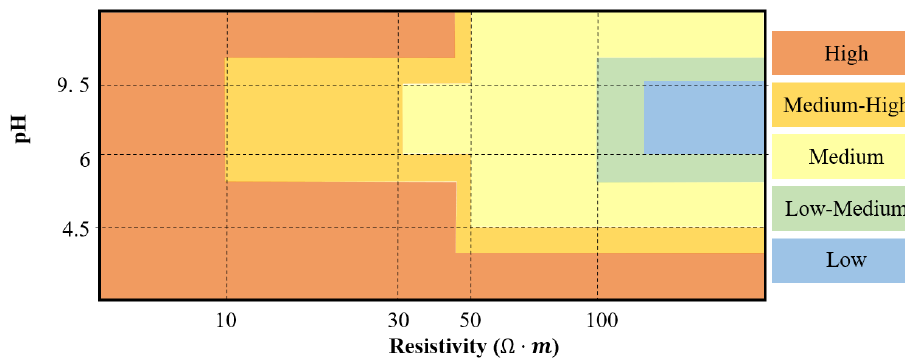
Figure 3. Soil corrosiveness based on the pH and resistivity according to BS EN